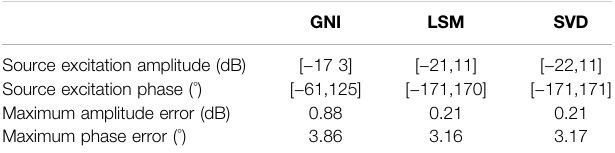
TABLE 3 | Comparison of simulation of different algorithms in 4.9 GHz.